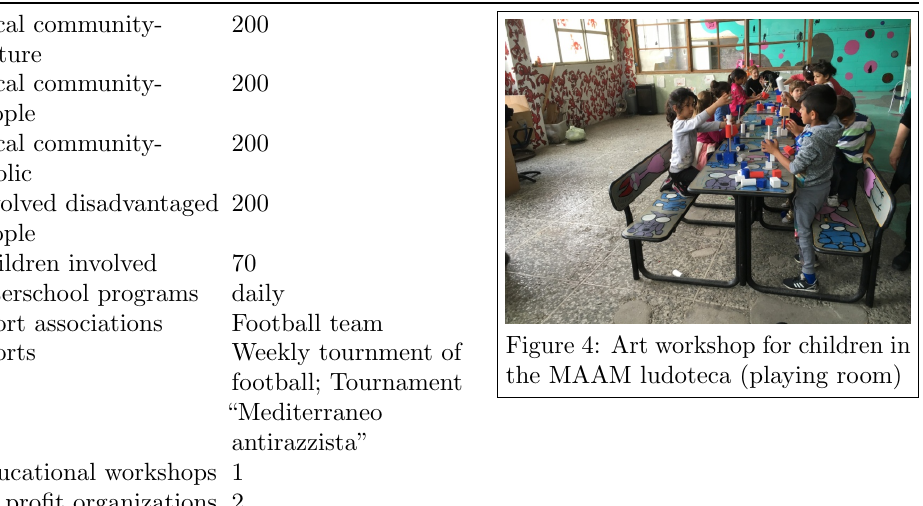
Figure 3: MAAM is part of the skyline of Roma Table 3: Internal relationships of heritage community